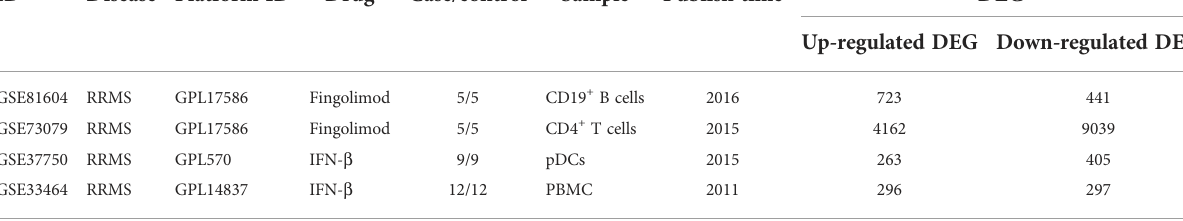
TABLE 2 Transcriptome datasets of MS patients before and after